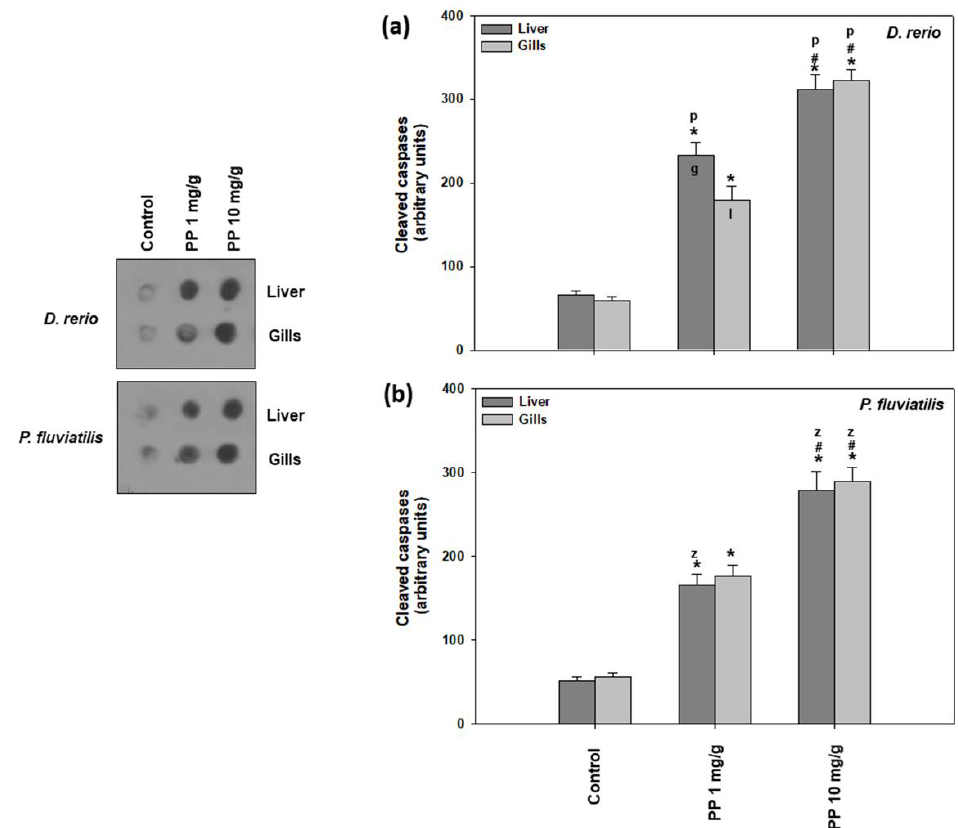
Figure 7. Cleaved caspase levels (mean ± SD) in the liver and gills of the Danio rerio ( a ) and Perca fluviatilis ( b ) control and dietary exposed to 1 mg PP-MPs /g and 10 mg PP-MPs /g dry food. Asterisk (*) denotes significant differences ( p < 0.05) compared to the control group, dash (#) denotes significant differences ( p < 0.05) between the two examined concentrations: 1 mg PP-MPs /g and 10 mg PP-MPs/g, lower case letters “z” and “p” denote significant differences ( p < 0.05) between the two examined species D. rerio and P. fluviatilis , respectively, while lower case letters “g” and “l” denote within species significant differences ( p < 0.05) between the gills and liver, respectively.